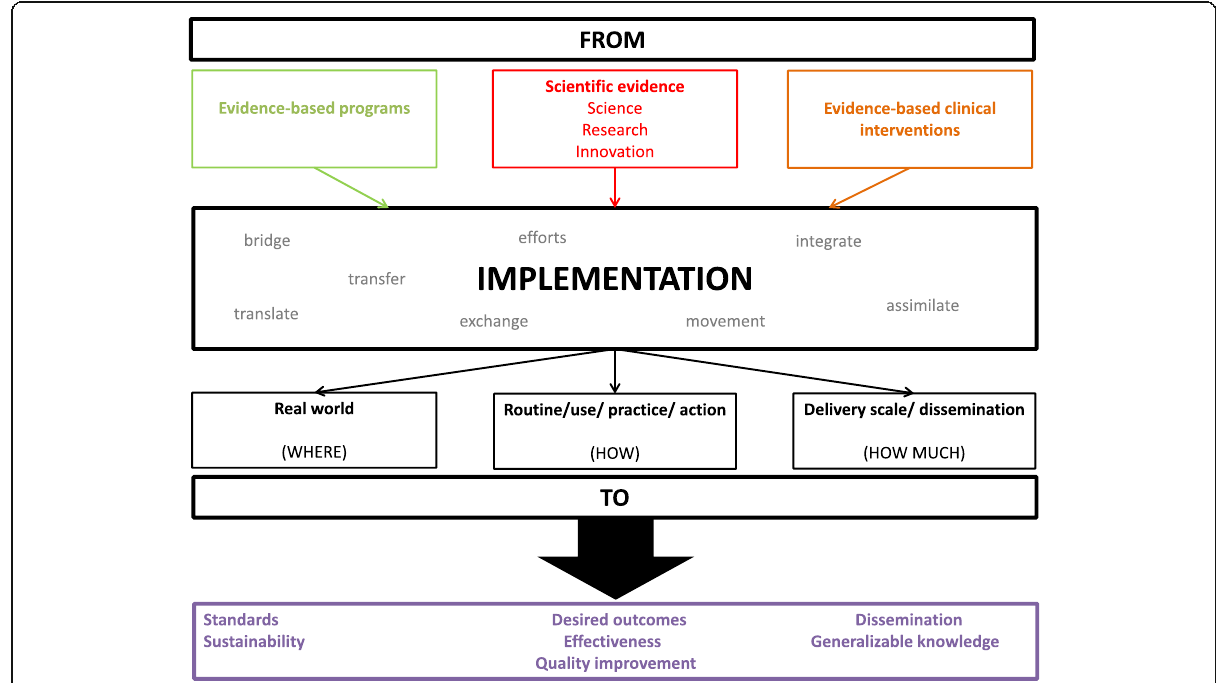
Fig. 2 Goals of Implementation Science. Source: Authors